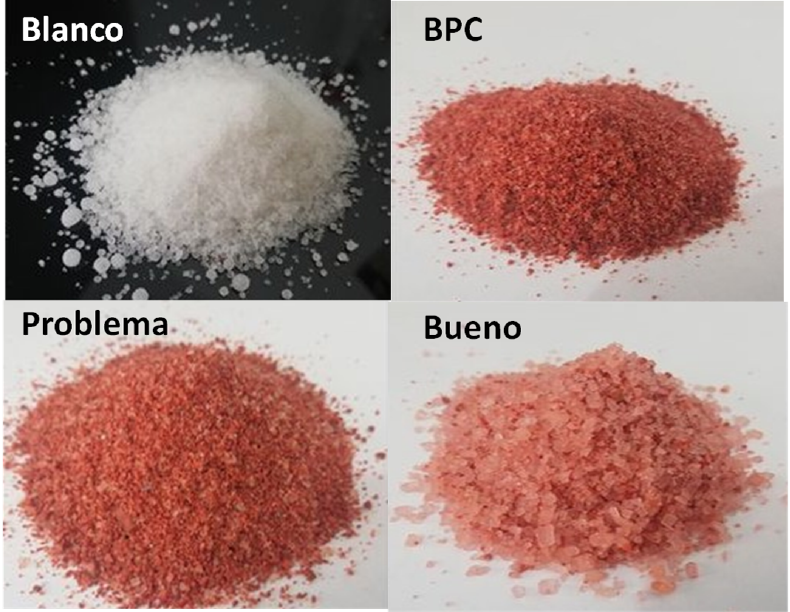
Figure 1. Photographic images of sylvite mineral samples from different deposits.